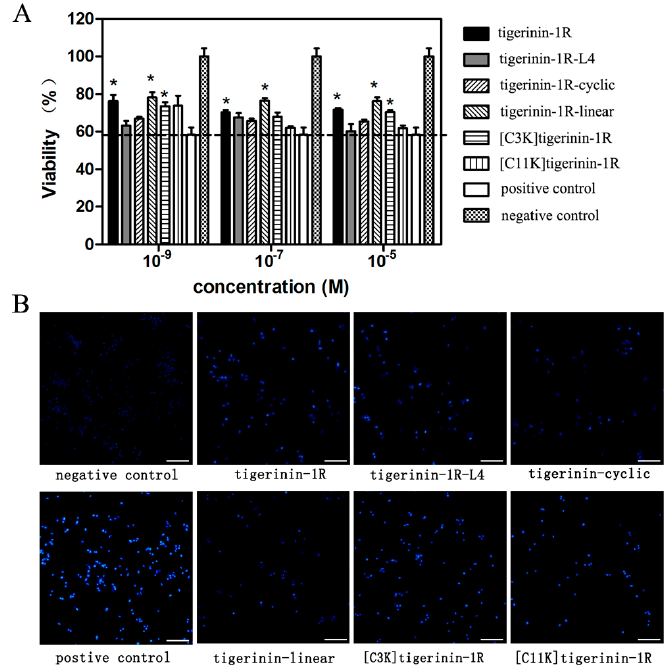
Figure 6. Protective effects of peptides against apoptosis induced by PA. ( A ) INS-1 cells were treated with different concentrations of peptides in the presence/absence of 0.5 mM PA for 24 h. The viability was tested by MTT assays. The value at the dotted line is equal to the group of positive control. (* p < 0.05 compared with positive control; n = 3) ( B ) INS-1 cells were treated with 10 − 5 M peptides in the presence/absence of 0.5 mM PA for 24 h. Nuclei were stained with Hoechst 33258 (in blue color). Scale bar = 100 μ m and refers to all panels.